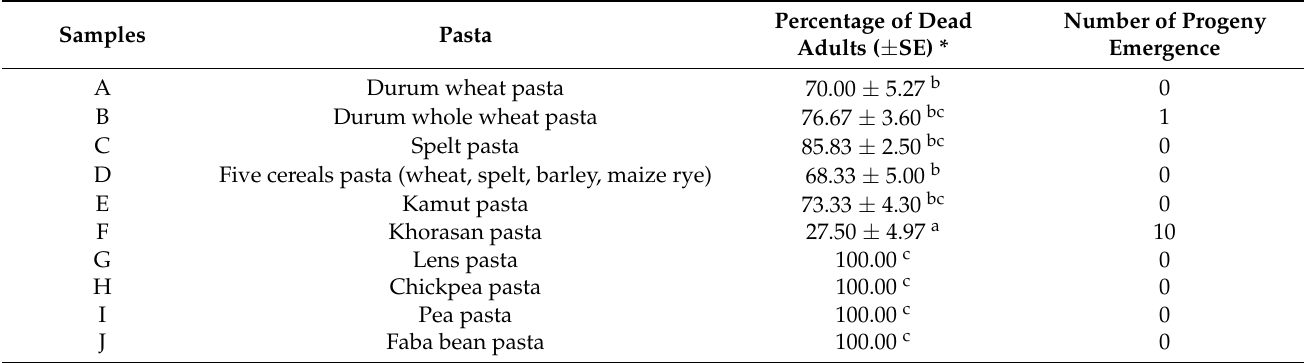
Table 3. Percentage of dead adults ( ± SE) checked after 20 days of contact with the macaroni pasta samples and number of progeny (F1)